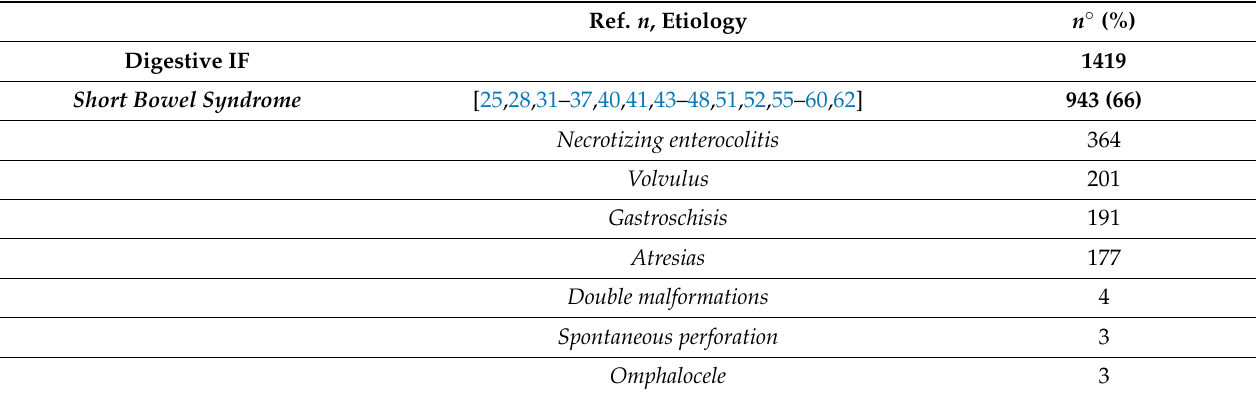
Table 2. Summary of the causes of Digestive Intestinal Failure